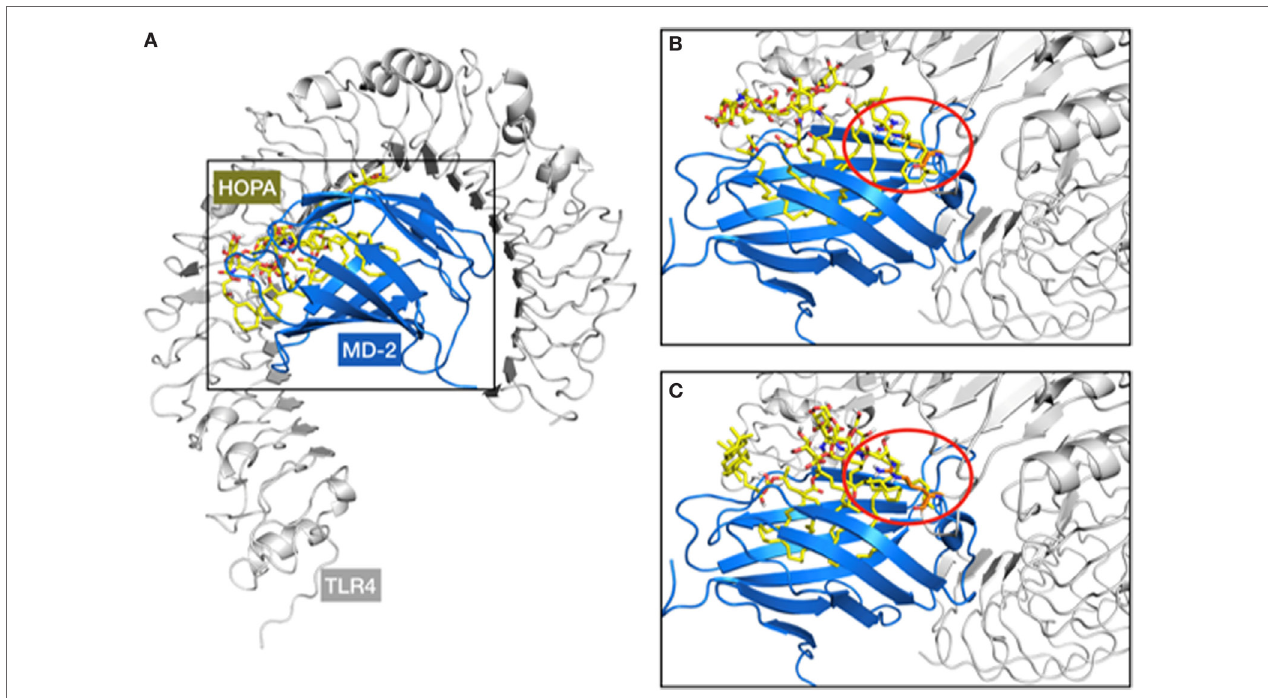
FigUre 6 | Representation of the steric clash observed over the superimposition of the myeloid differentiation protein-2 (MD-2)/HOLA complex (from docking calculations) to the MD-2/toll-like receptor 4 (TLR4) structure (from PDB ID 3FXI). A general view of the MD-2/TLR4/HOPA complex (a) and two examples of steric clashes are given (B,c) . TLR4, MD-2, and HOPA are respectively represented in gray cartoon, blue cartoon, and yellow sticks. The TLR4 protruding loop mentioned in the text is marked within the red circle, involving the hopanoid moiety (B) and one of the short acyl chains of HOPA (c)